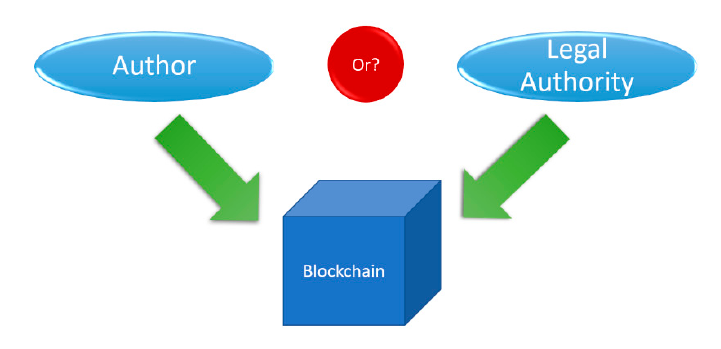
Figure 3. Selecting the appropriate oracle.